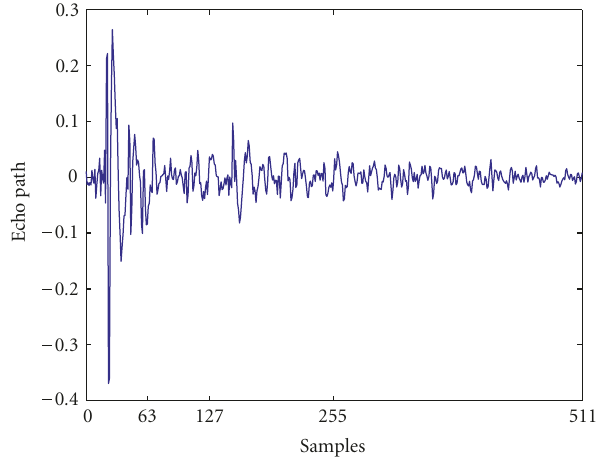
Figure 5: Impulse response of the echo path measured in a room.